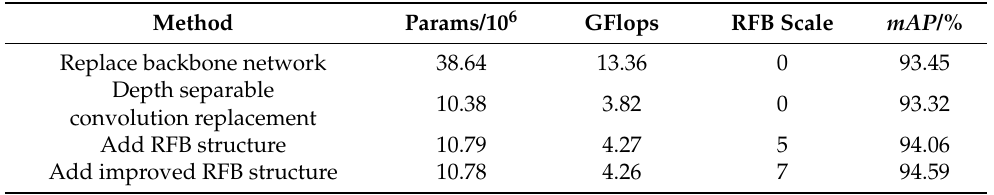
Table 5. Accuracy comparison of RFB structure improvement.